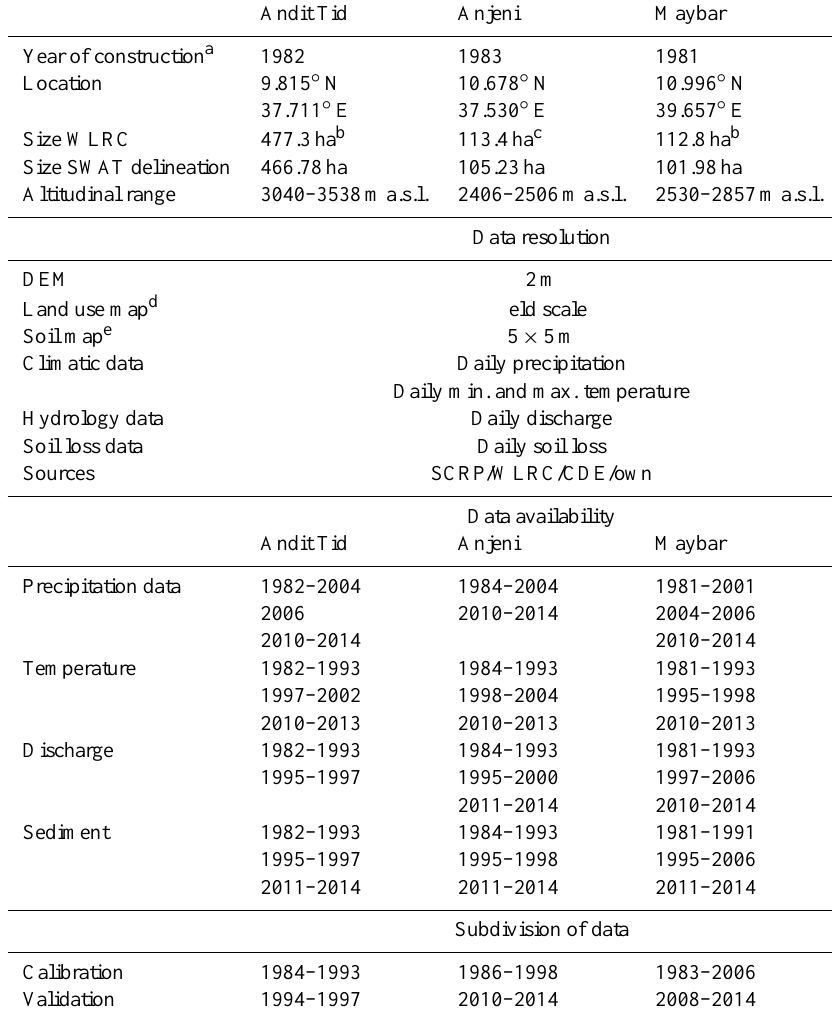
Table 1. Description of study sites, data sources, and time series and gaps. The subdivision of data relates to calibration and validation